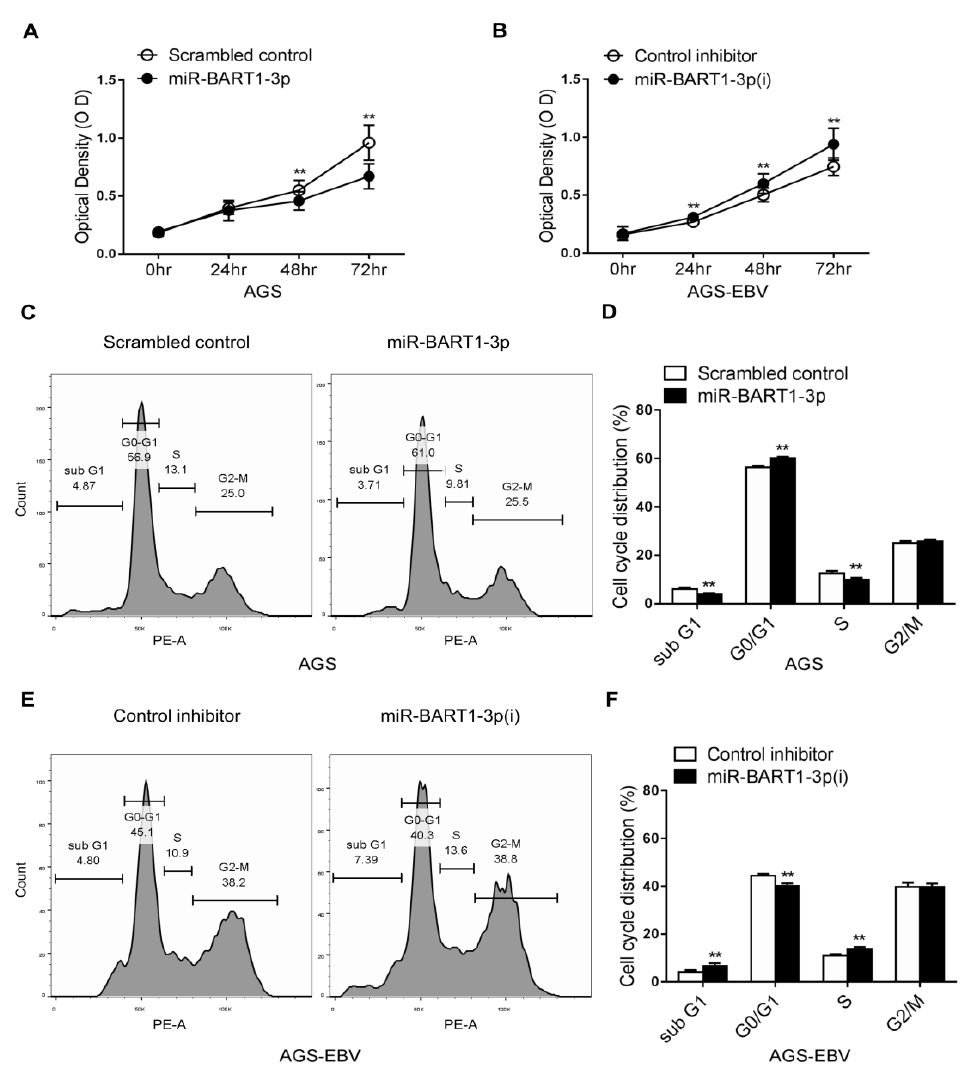
Figure 1. Cell cycle regulation by miR-BART1-3p. The AGS and AGS-EBV cells were transfected with either the miR-BART1-3p mimic ( A ), ( C ), and ( D ) or the miRVana-miR-BART1-3p(i) ( B ), ( E ), and ( F ). ( A ) and ( B ) At the indicated times after transfection, 20 µL of MTT solution was added to each well to assess cell proliferation. ( C ), ( D ), ( E ), and ( F ) The cells were stained with PI and subjected to FACS analysis 48 hr after transfection. Three sets of independent experiments were performed, and representative results ( C ) and ( E ) and mean +/− SD values ( D ) and ( F ) are shown. The data were analyzed using Student’s t -test. Error bars indicate the SD ( n = 3). **, p < 0.01.